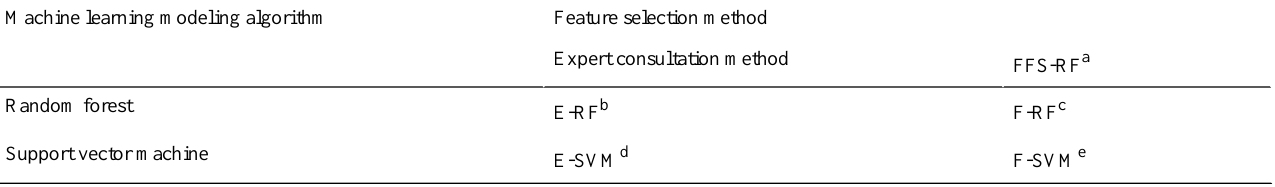
Table 1. Names of the postpartum depression prediction models.